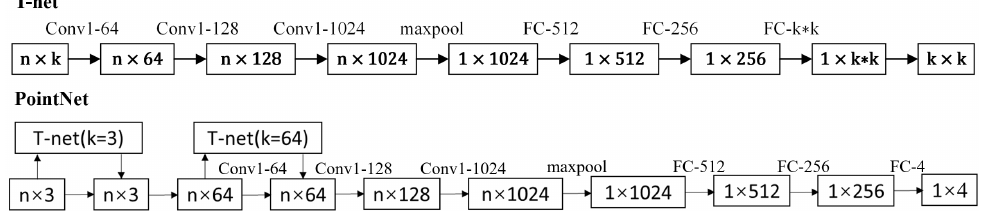
Figure 8. The network structure of T-net and